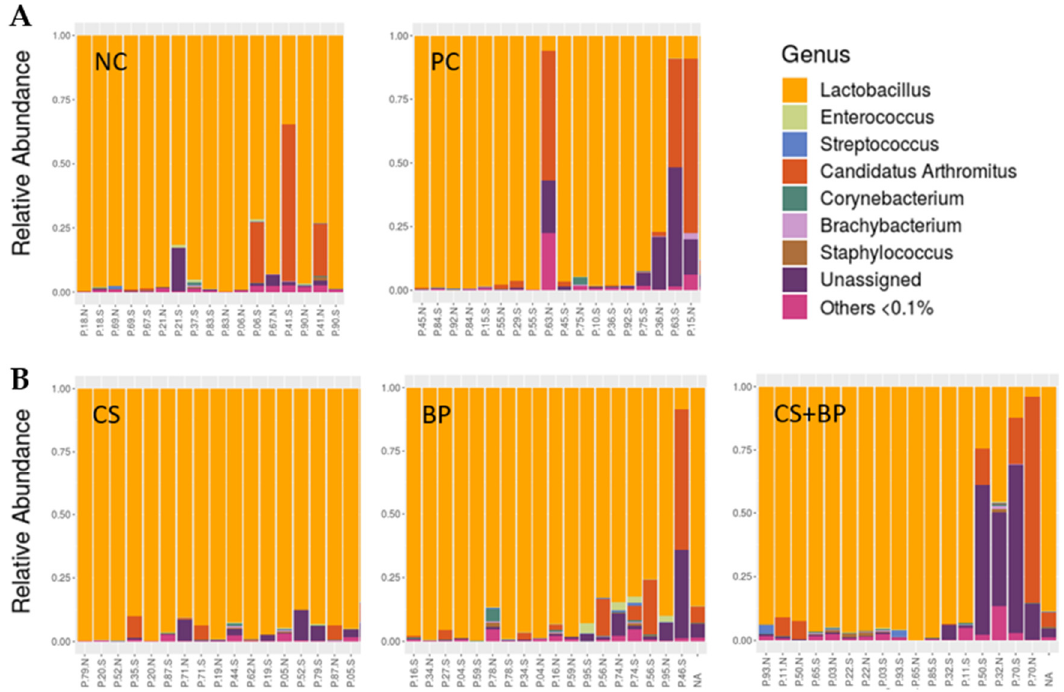
Figure 3. Composition of the jejunal bacterial communities in five different groups of broilers at the genus level using ( A ) group average and ( B ) individual samples.